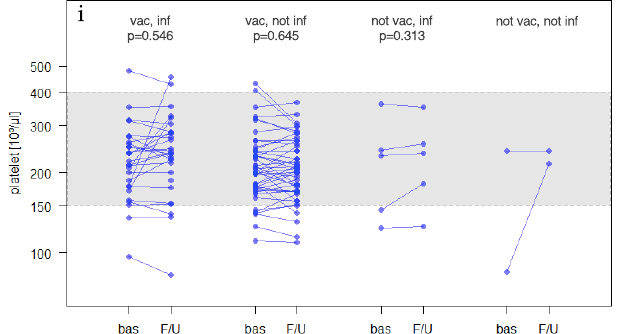
Figure 1. Course of different aPLs and platelet counts for different subgroups according to vaccination and infection status. Panels ( a – c ) show lupus anticoagulants (DRVVT ratio and screening with (+) and without (−) VKA and MIXCON LA ratio), panel ( d ) shows anti- β 2-GPI domain I IgG antibodies, panels ( e , f ) show anti- β 2-GPI IgM- and IgG-antibodies, panels ( g , h ) show aCL IgM- and IgG-antibodies, and panel ( i ) shows the platelet counts. The vertical axes are on log-scale. p -values were calculated with the Wilcoxon-matched pairs test on a logarithmic scale. The shaded area shows the reference ranges of each assay. Points are shaded and a stronger color is caused by overlaying the data points. The DRVVT ratio is only evaluated in patients with positive DRVVT screening. Only these quantifications were statistically compared but the respective panel also illustrates cases with negative screening (with overlaying data points). vac.: COVID-19 vaccination; inf.: COVID-19 infection; Scr. neg: screening negative; bas: baseline; F/U: follow-up; DRVVT: dilute Russell ’s viper venom time; VKA+: patients on vitamin K antagonist treatment; VKA – : patients without vitamin K antagonist treatment; MIXCON-LA: a lupus-sensitive aPTT-based assay; Anti- β 2-GPI: Anti- β 2-Gly- coprotein I; IgG: Immunoglobulin G; IgM: Immunoglobulin M; aCL: anticardiolipin antibody; plate- let: platelet count. Table 4. Effect of COVID-19 vaccination and/or infection on antiphospholipid antibodies and plate- let count. Comparisons of different parameters at baseline and follow-up. Total Study Population COVID-19 vac. only COVID-19 vac. and inf. ** COVID-19 inf. only Median